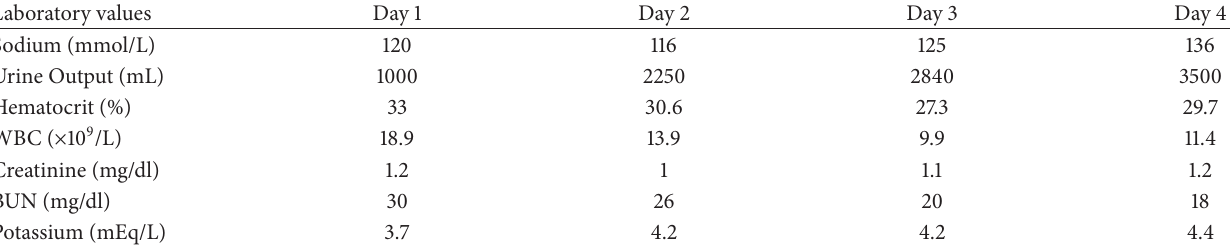
Table 1: Trend of pertinent postoperative clinical and laboratory data.